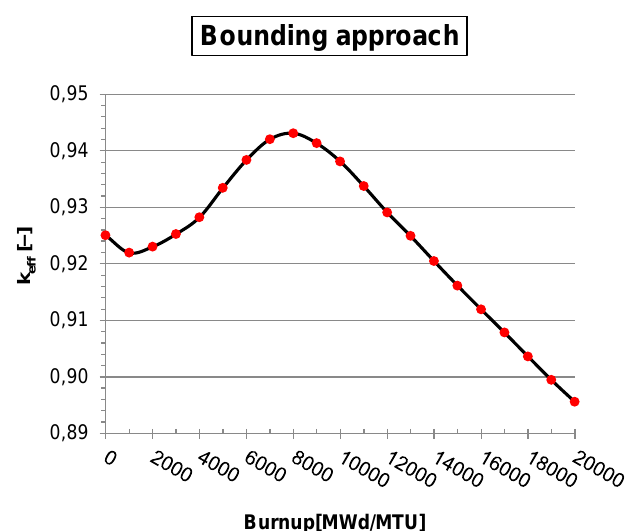
Fig. 3. Multiplication factor based on fuel burnup calculated by bounding approach with correction factors on spent fuel pool model.